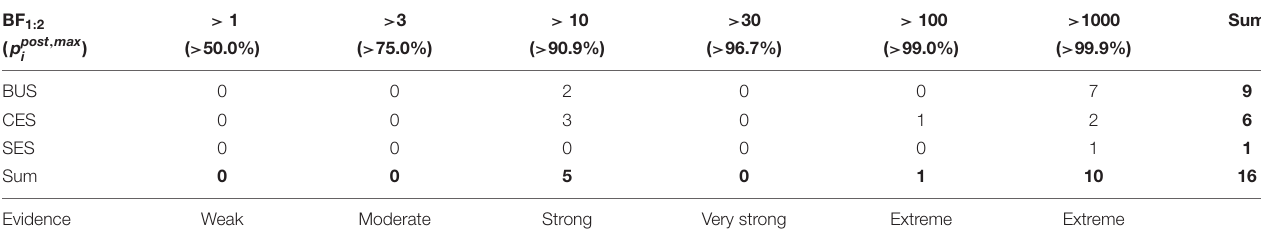
TABLE 8 | Certainty of classification of participants in interaction explication condition.